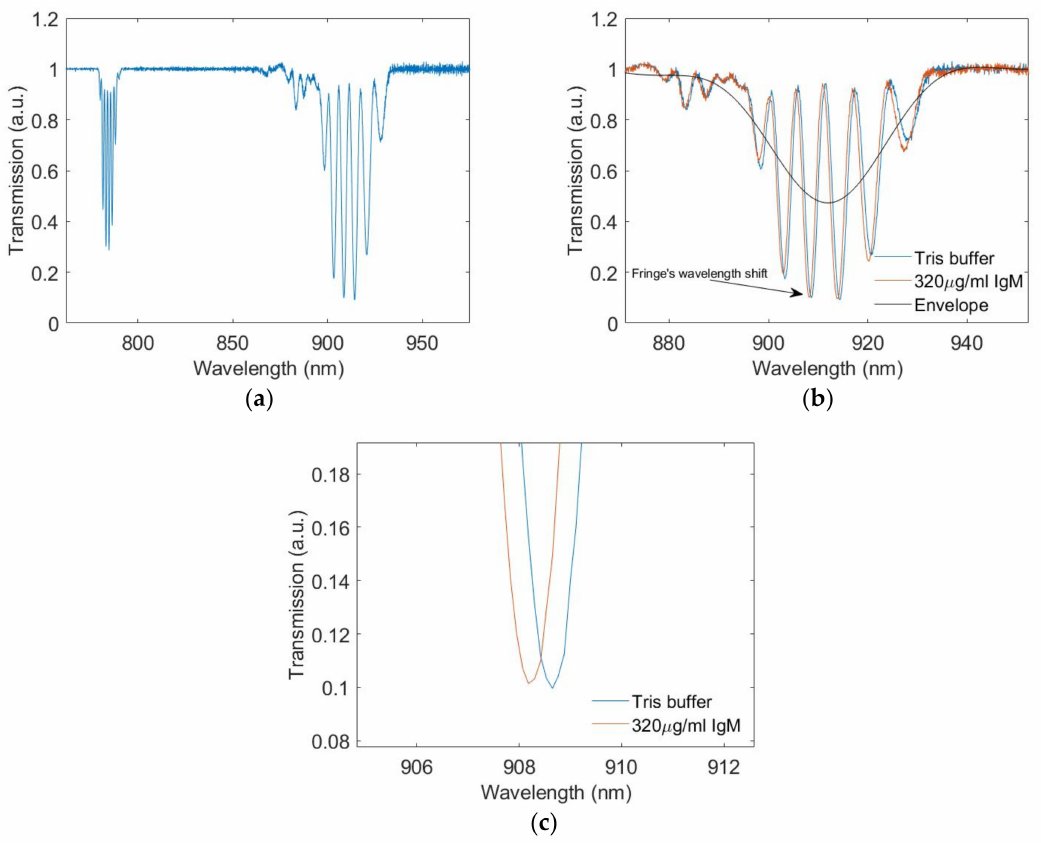
Figure 5. ( a ) Comparison between different attenuation bands in the transmission spectrum. ( b ) The transmission spectra of the LPGMZI when the connecting section is immersed in solutions with different IgM concentrations. ( c ) The wavelength shift of a fringe during the